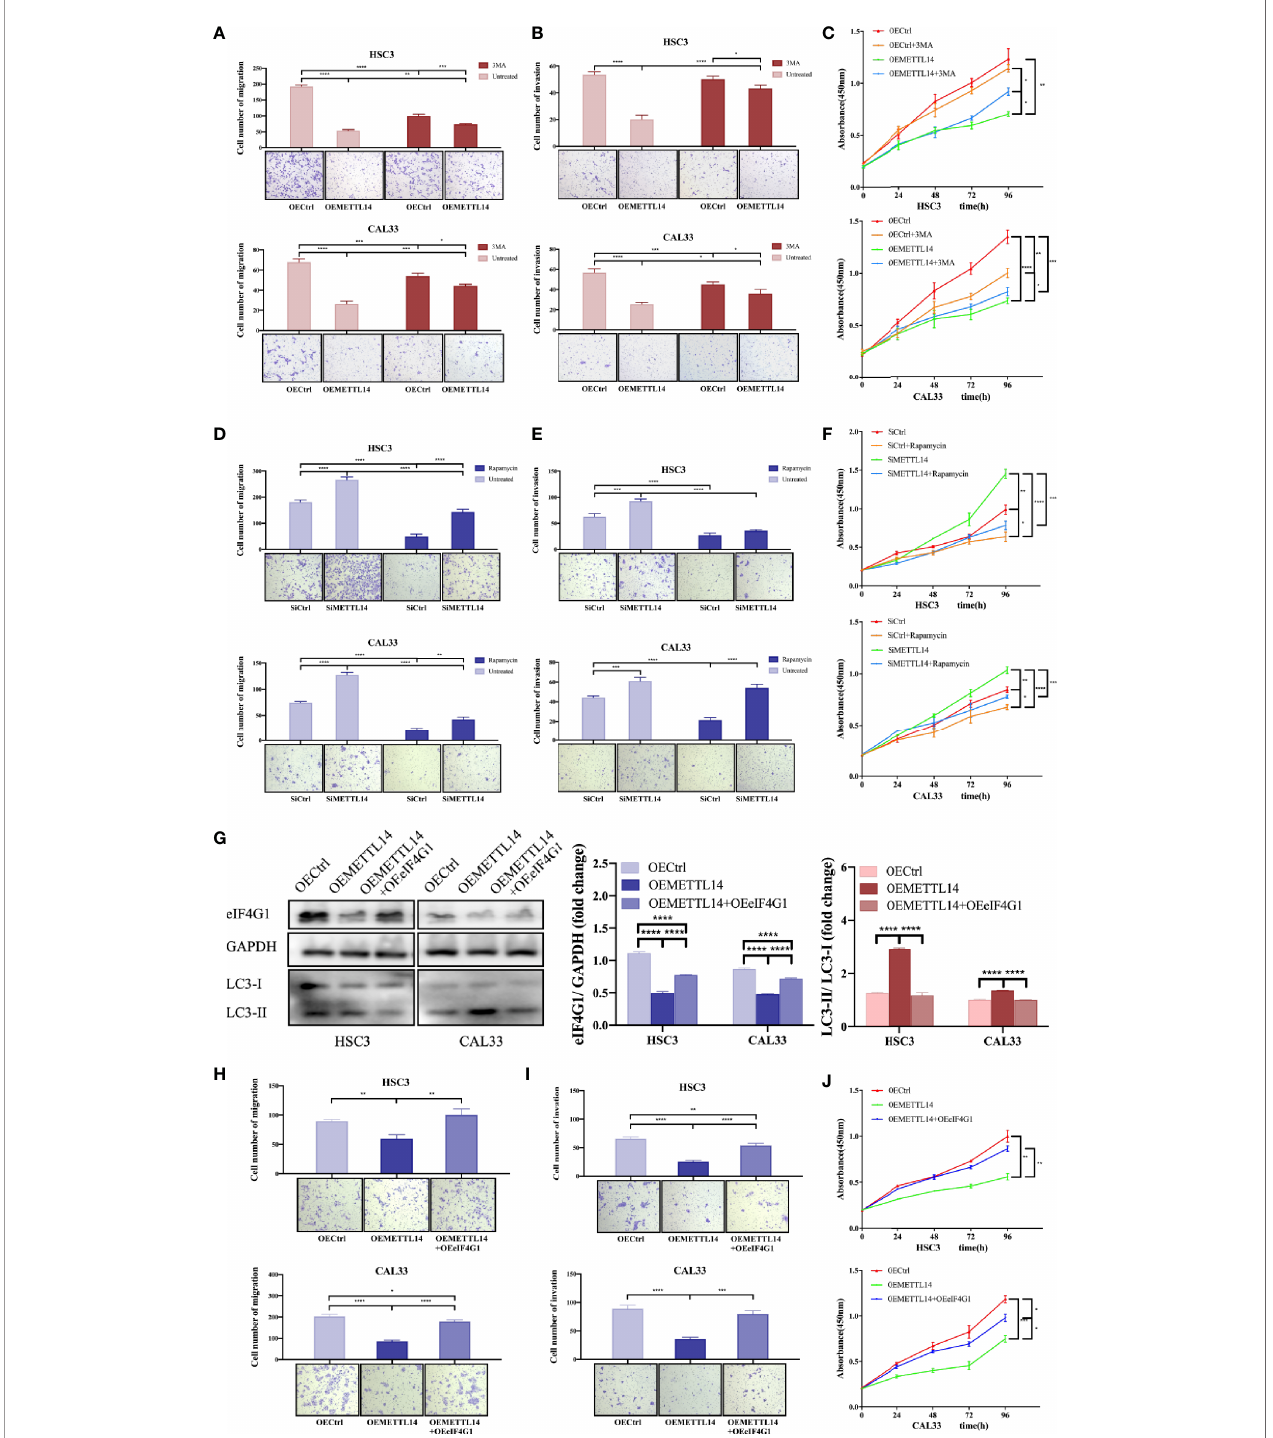
FIGURE 4 | METTL14 regulates autophagy and biological functions of OSCC cells by mediating eIF4G1 expression. Transwell assays were used to detect the migratory and invasive abilities of HSC3 and CAL33 cells (one-way ANOVA). Proliferation of HSC3 and CAL33 cells was detected using CCK8 assays (one-way ANOVA). One group of cells were transfected with OEMETTL14 or OECtrl and cultured with or without 3MA (A – C) , while the other group was silenced using siMETTL14 or siCtrl and rescued using rapamycin or not (D – F) . (G) Western blot was used to compare expression levels of eIF4G1, LC3-I, and LC3-II in HSC3 and CAL33 cells transfected with OECtrl, OEMETTL14, and OEMETTL14+OEeIF4G1. (H – J) The migration, invasion, and proliferation of OSCC cells with eIF4G1 overexpression and METTL14 knockdown. ( p or adjusted- p *< 0.05, **< 0.01, ***< 0.001, ****<